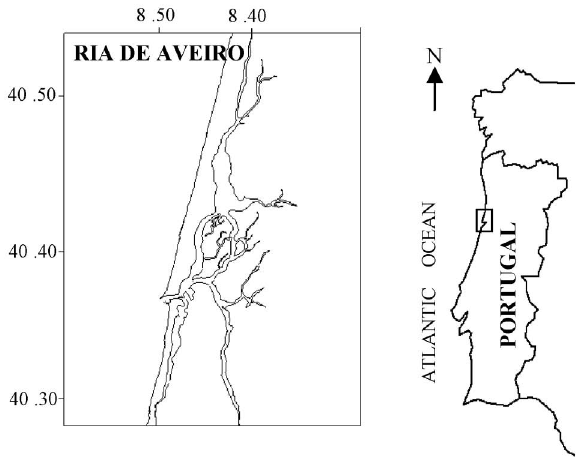
Fig . 1. – Ria de Aveiro